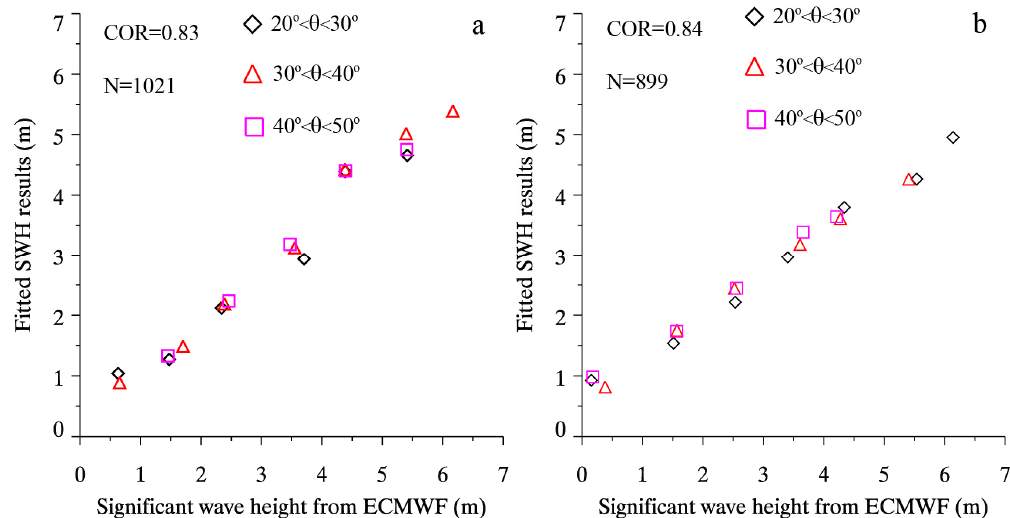
Figure 5. ECMWF SWH data versus fitted SWH results, for 10° incidence angle bins between 20° and 50° and 1 m/s SWH bins ranging from 0 to 7 m/s: ( a ) VV-polarization; and ( b ) HH-polarization.